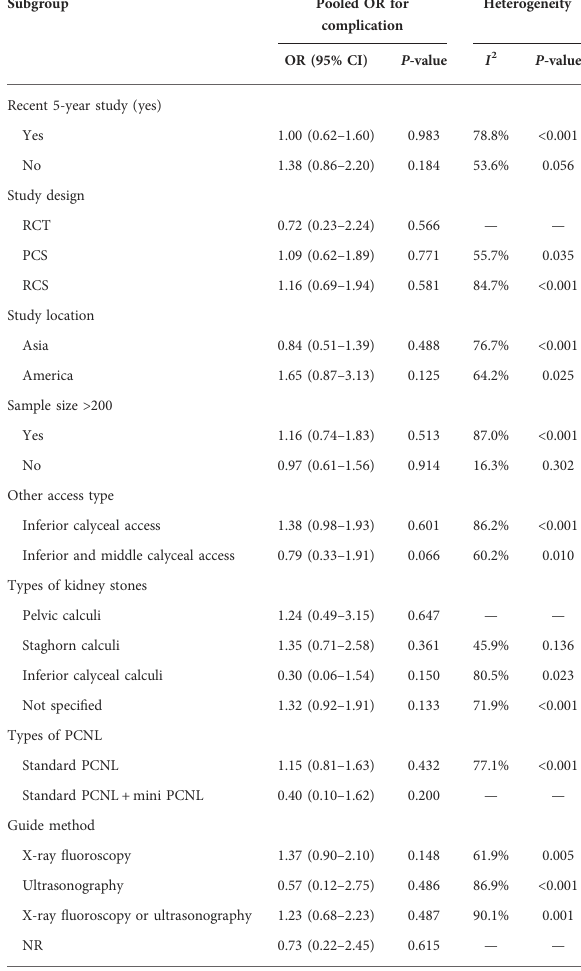
OR, odds ratio; CI, con fi dence interval; RCT, randomized controlled trial; PCS, prospective cohort study; RCS, retrospective cohort study; PCNL, percutaneous nephrolithotomy; NR, not